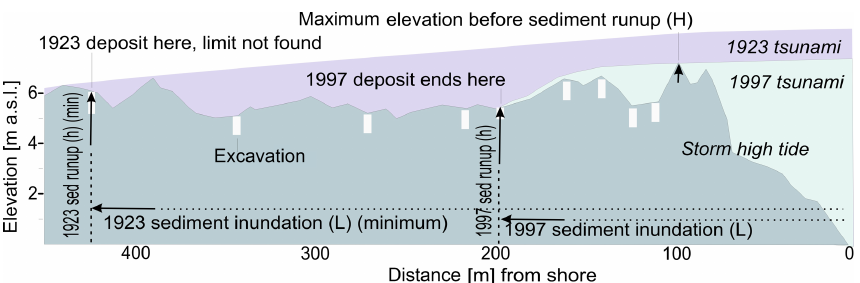
Figure 5. Terminology for sediment runup and sediment inundation, and interpretation of deposits from 1997 and 1923, using example of an actual profile (Storozh 160; vertical exaggeration ∼ 10). Near the shoreline on this profile, both tsunamis had to exceed a point ( H ) higher than “sediment runup” ( h ) and, although the minimum sediment runup for 1923 is not much greater than for 1997, 1923 was likely higher to have generated greater inundation, which is also related to tsunami wave length. Note that a 2-D interpretation of (orthogonal) tsunami flow over this and most study profiles is justified by the lateral continuity of ridges. In a few cases (discussed in the text), the tsunami may have reached a runup/inundation point via a lower, more circuitous route. Distances and elevations are from